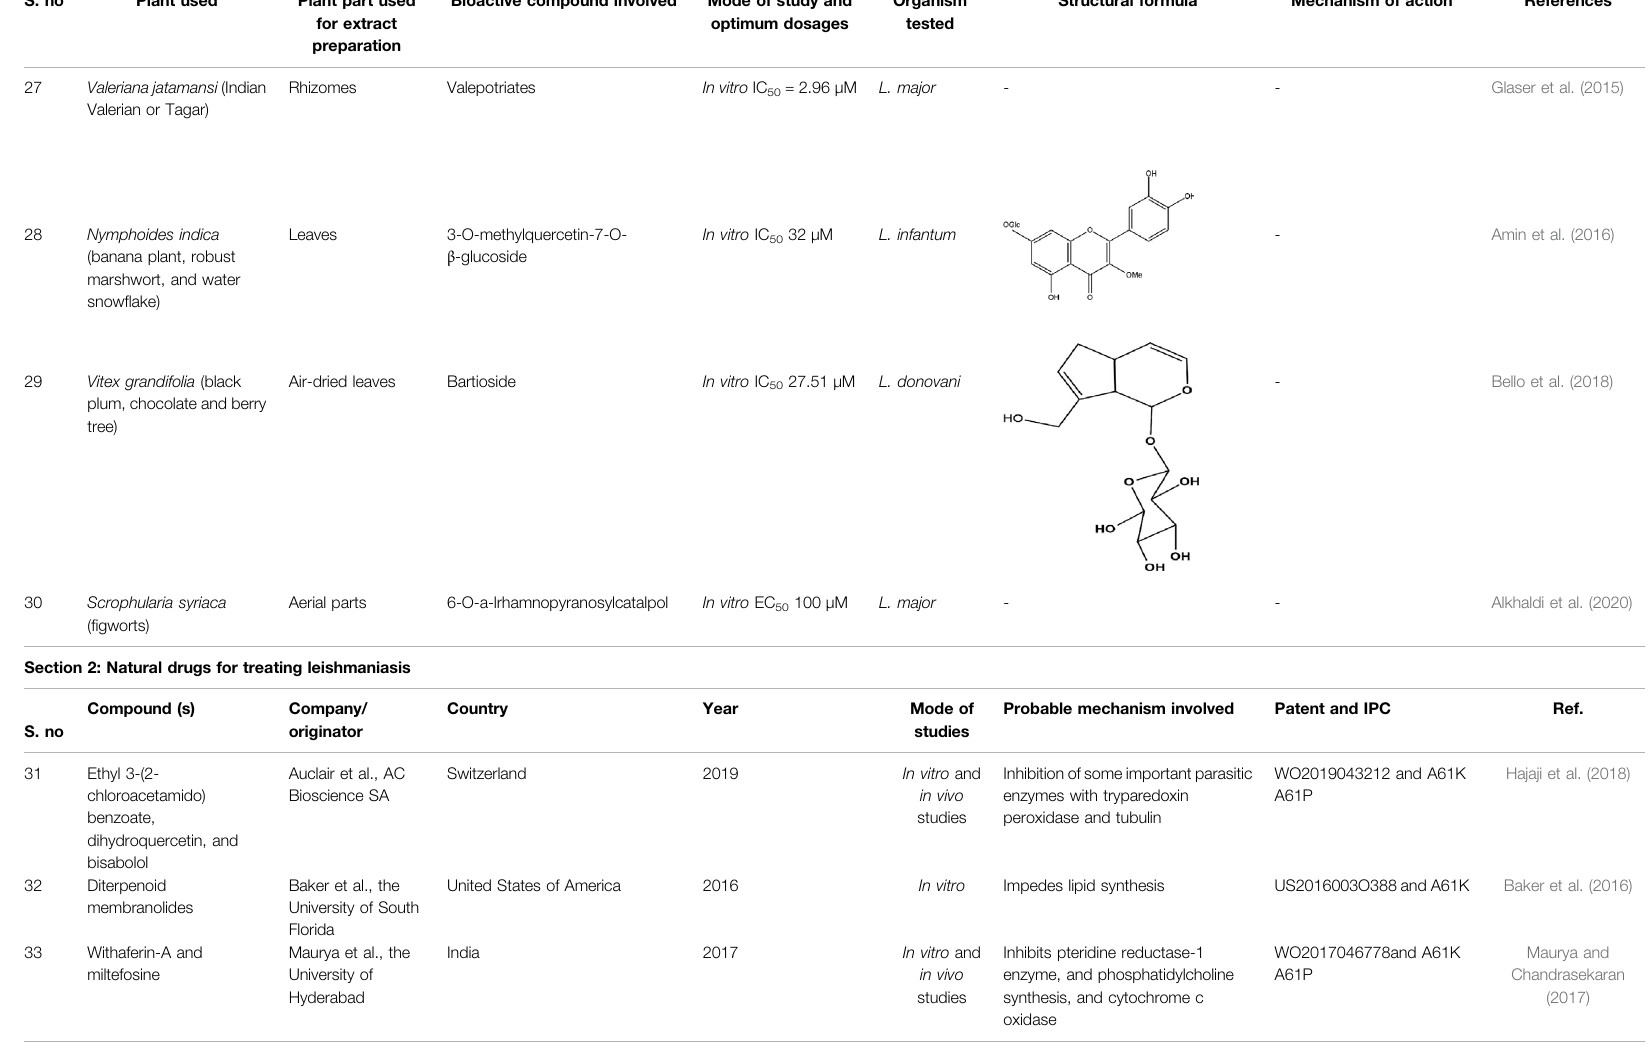
TABLE 1 | ( Continued ) Role of plant-based natural products in the treatment of leishmaniasis. S. no